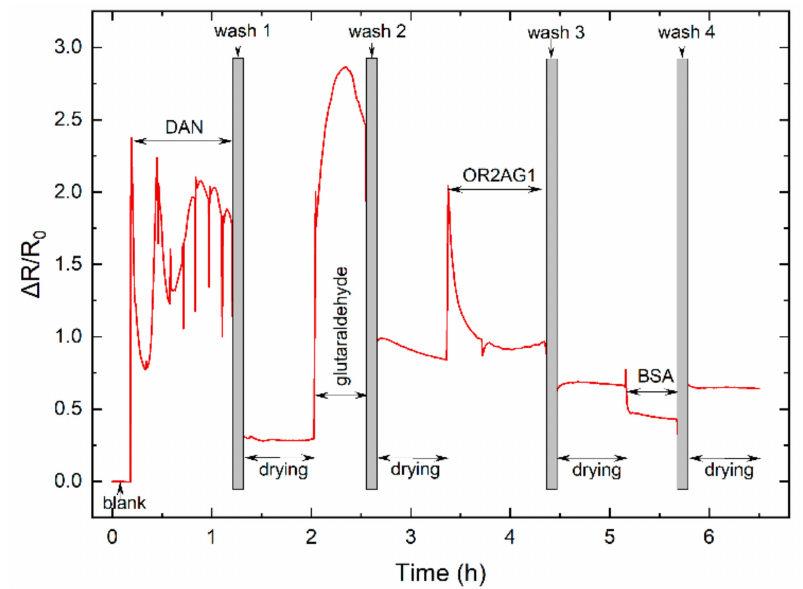
Figure 6. Real-time resistance measurements of the graphene functionalization process, where ∆ R/R 0 = R device – R 0 /R 0 , and R 0 is the resistance at T = 0 (resistance of bare (intrinsic) graphene).